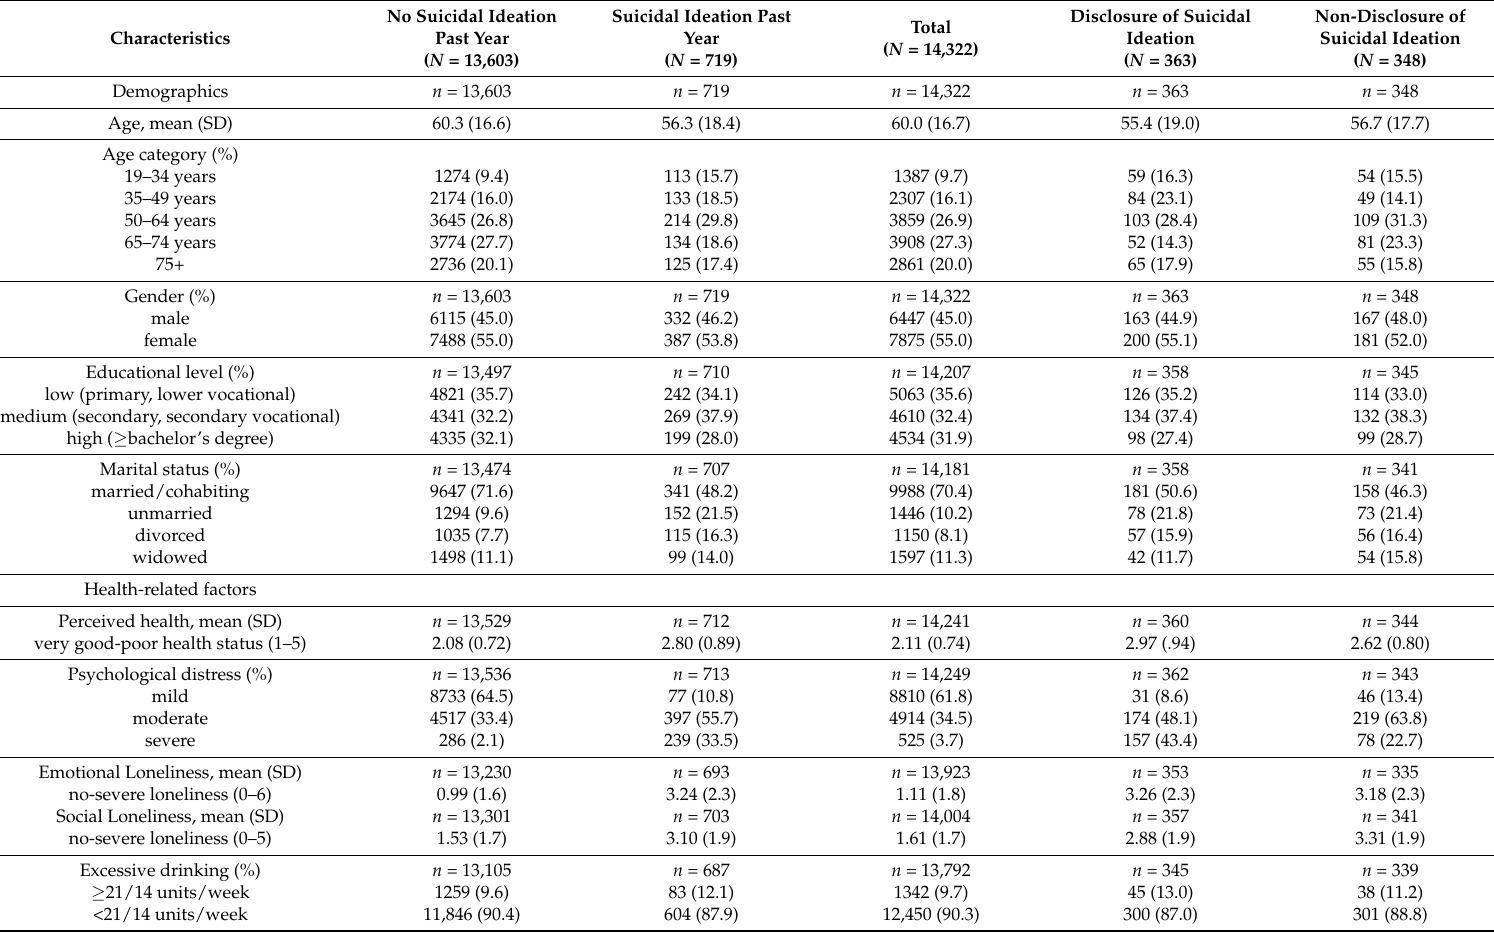
Table 1. Characteristics of the study